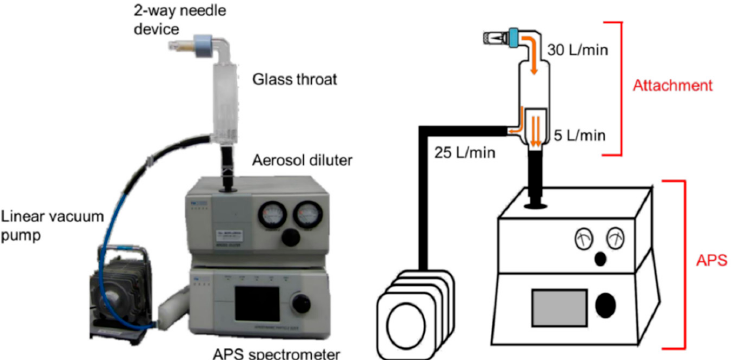
Figure 1. The aerodynamic particle sizer (APS) system with dispersion attachments. Grass throat and linear vacuum pump were added so that formulations can be dispersed under the same condition as for multi-stage liquid impinger measurement (flow rate of 30 L / min at a pressure drop of 4 kPa with two-way needle device). Dispersed particles are measured at flow rate of 5 L / min, which is the standard flow rate for APS measurement.